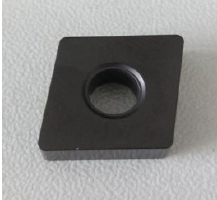
Figure 1. TiAlN-coated.